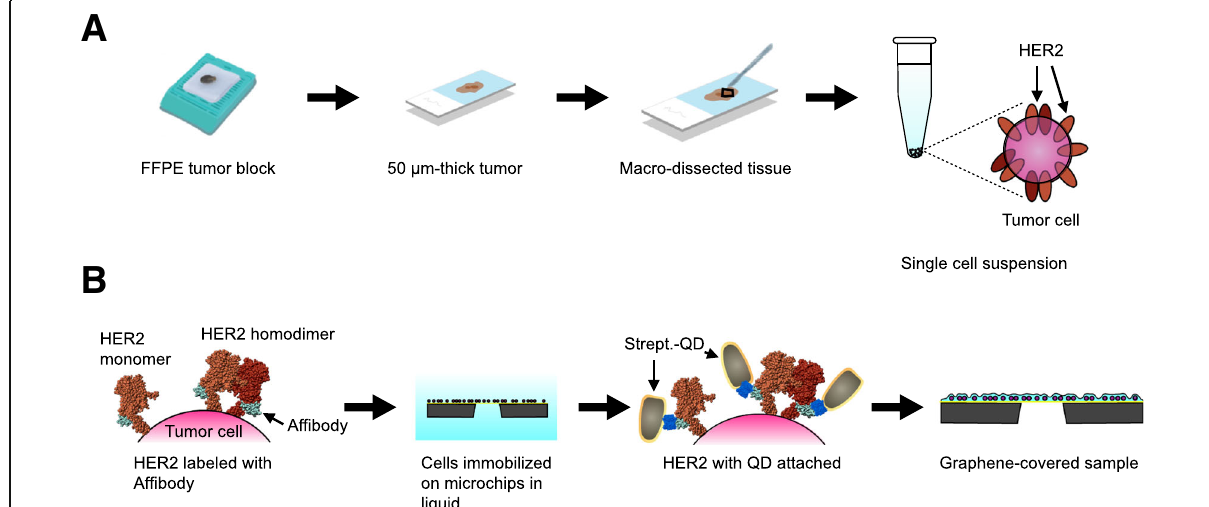
Fig. 2 Schematic representation of the sample preparation method. a Retrieval of a single cell suspension from an FFPE tumour block. The tumour block is first sectioned. The tumour is then macro-dissected and transferred into a tube for single cell retrieval by collagenase and dispase digestion. b HER2 membrane proteins are specifically labelled with Affibody peptides. The cells are then immobilized on a microchip, and streptavidin Quantum Dot (Strept.-QD) is attached. The final step is the coverage of the sample with a graphene sheet